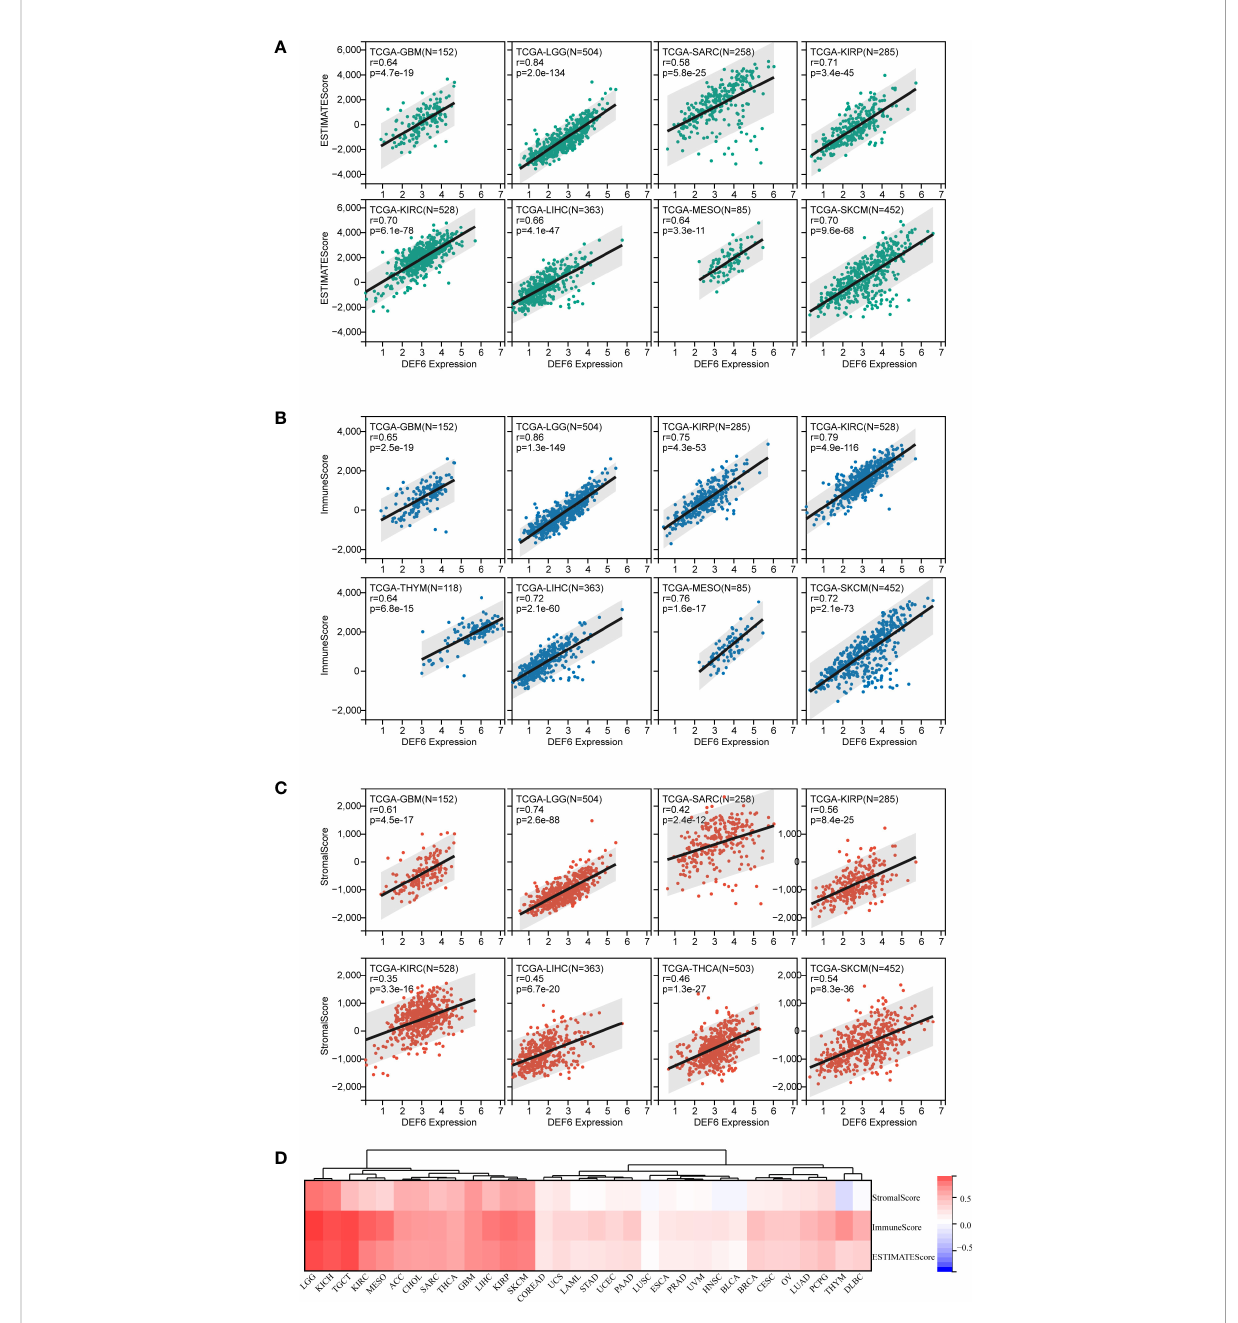
FIGURE 8 Correlation of DEF6 expression with immune in fi ltration. (A – C) The eight types of cancer with the strongest correlation between DEF6 expression and ESTIMATE score, IMMUNE score, and stromal score. (D) The heatmap demonstrates the overall pro fi le of the correlation between DEF6 expression and immune in fi ltration